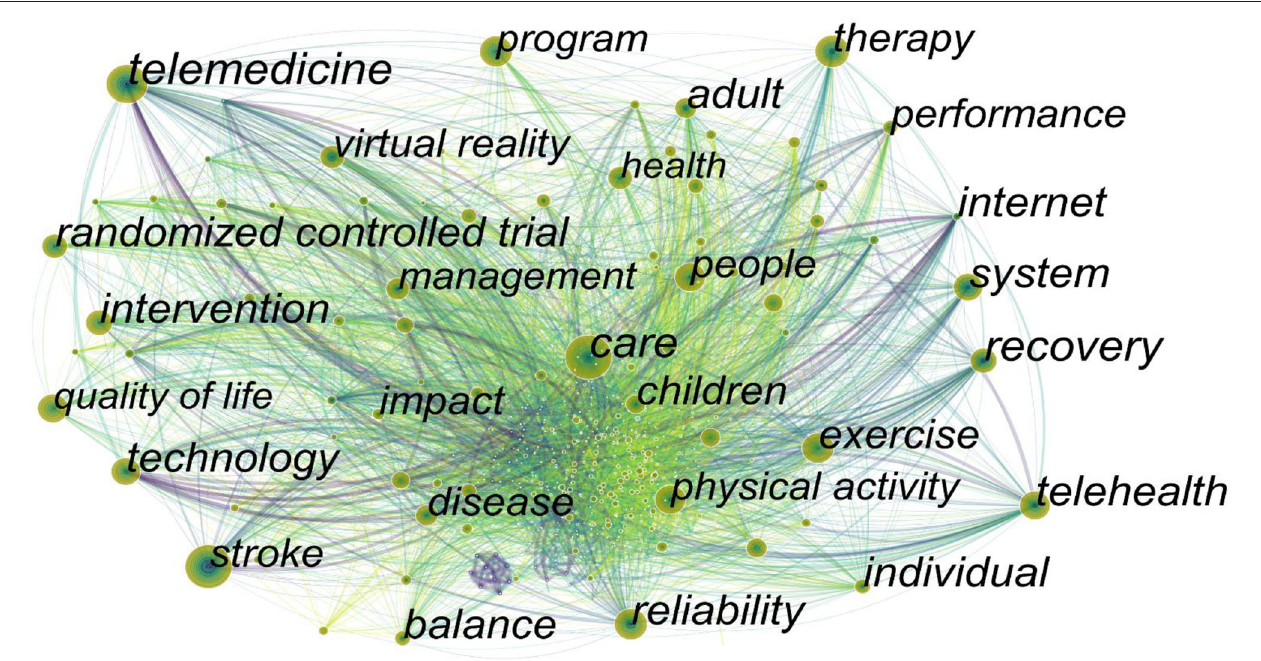
FIGURE 9 | Map of keywords to telerehabilitation from 2000 to 2021.